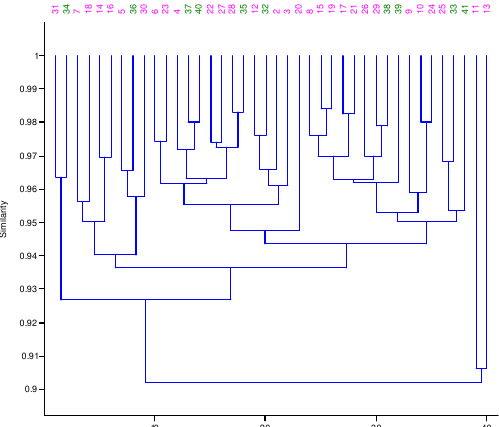
Fig. 12. Dendrogram showing similarity coefficient (90.2%) of the meristics of right side of cultured Clarias gariepinus employing the Bray-Curtis’s clustering algorithm *Pink color indicates male, green color indicates